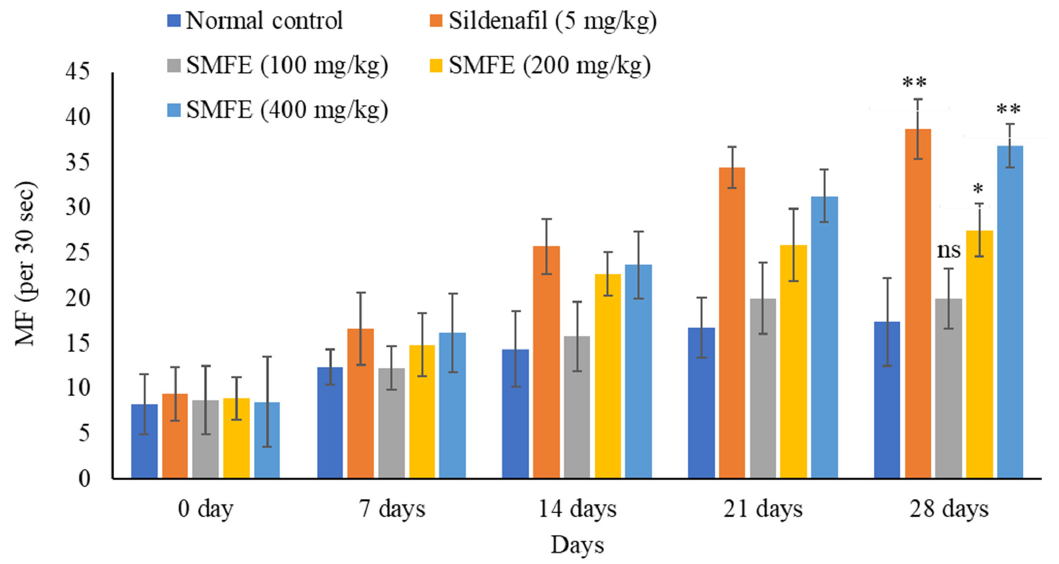
Figure 4. Effect of S. mangifera fruit extract on mount frequency ( n = 6). The values are means ± SEM; * p < 0.05, ** p < 0.1; ns p > 0.05 (followed by Student Dunnett test).